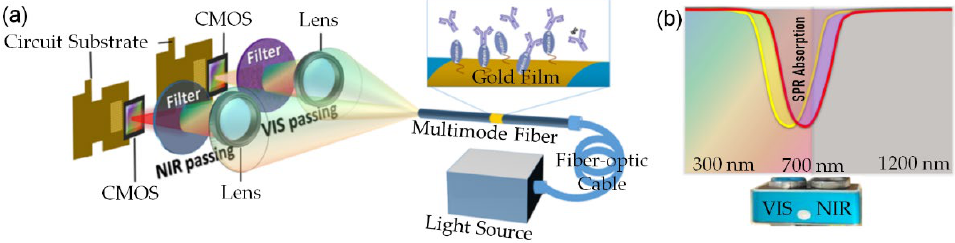
Figure 1. ( a ) Schematic diagram of a dual-camera FO-SPR sensing device; ( b ) principle of detecting the change of SPR absorption by VIS and NIR cameras. (The yellow and the red lines, respectively, represent the spectrum of the RIs of the external environment from small to large.)